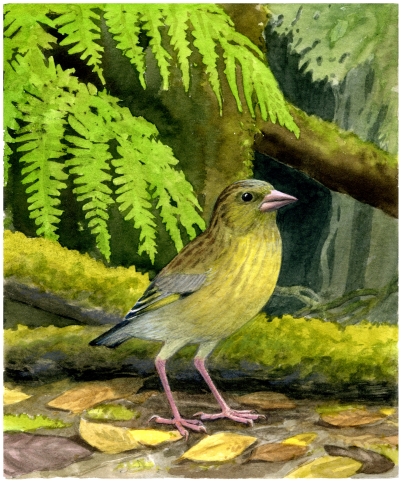
Reconstruction of Carduelis aurelioi n. sp. (slender-billed greenfinch) at laurel forest, art by A. Bonner.